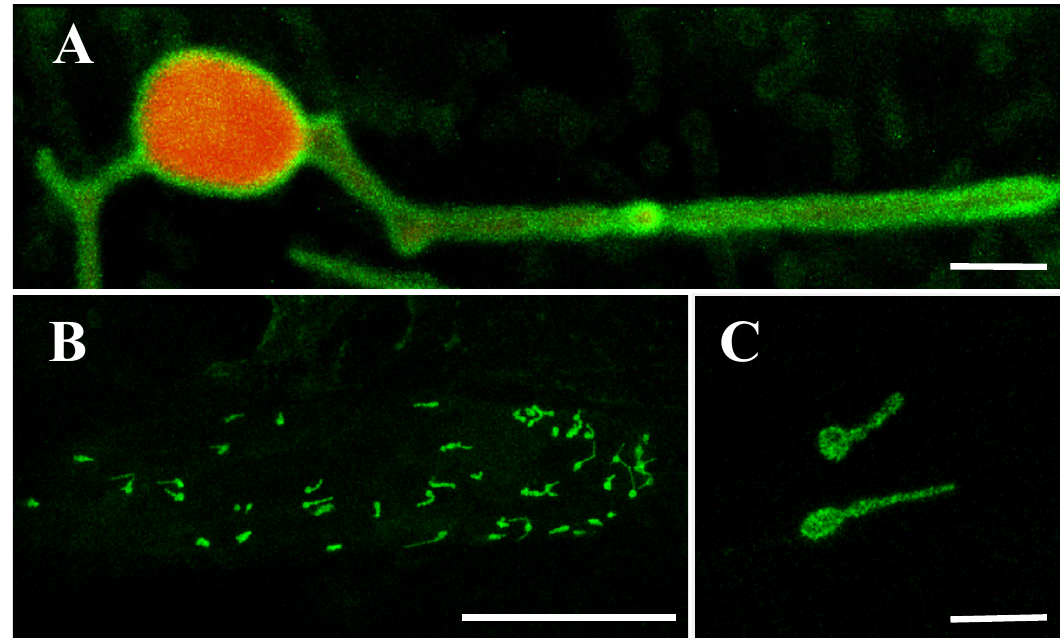
Figure 6. BiFC analysis of OsLACS9-nYFP and OsLACS9-cYFP. Images show onion epidermal cells expressing: ( A ) Transient expression of OsLACS9-GFP (green) and WxTP-DsRed (plastid stroma marker, red). Bar = 2 µ m. ( B , C ) OsLACS9-nYFP and OsLACS9-cYFP. The green color represents nYFP / cYFP complex. Bars in ( B , C ) represent 100 and 10 µ m, respectively.